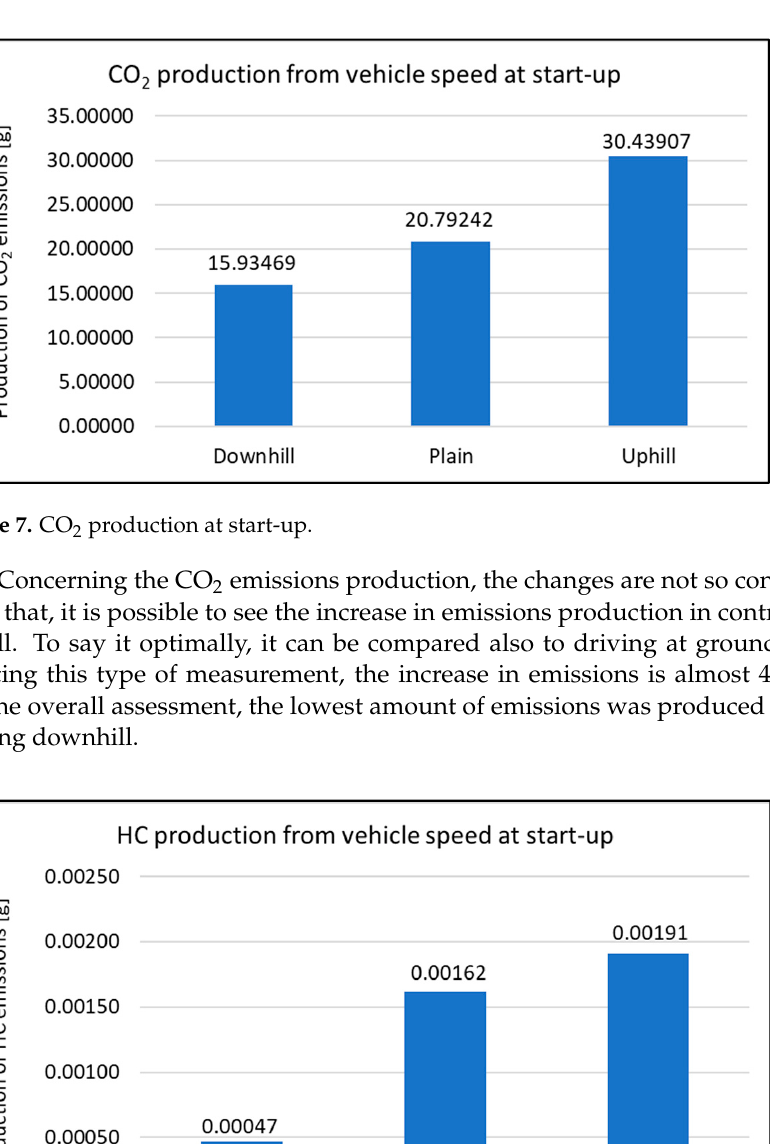
Figure 9. NO X production at start-up. Based on the measurements in terms of the assessment of the driving tests, it can be concluded that a vehicle represents the lowest pressure on the environment when driving downhill. It is also proved by Figure 10, which displays the route on which the vehicle emissions have a rising course.